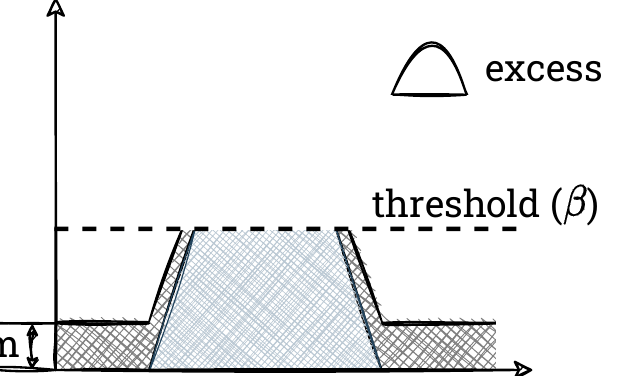
Figure 5. The second stage of the redistribution procedure: the first iteration of redistribution may result in some remaining